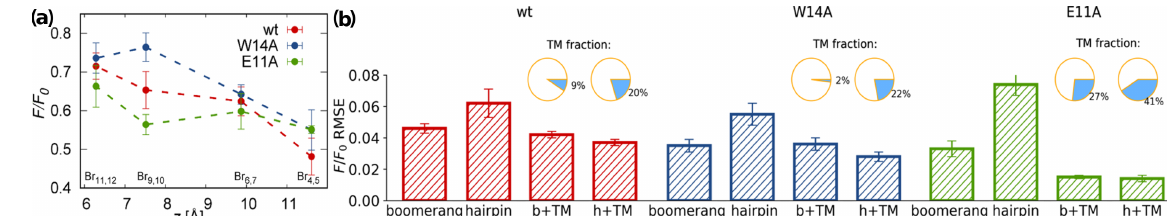
Figure 5. ( a ) Experimentally determined fluorescence quenching ratio, F / F 0 , for peptides in brominated lipids; and ( b ) RMSE values for best fit between experimental and calculated F / F 0 . Circle plots indicate the fraction of transmembrane configuration providing the lowest RMSE.